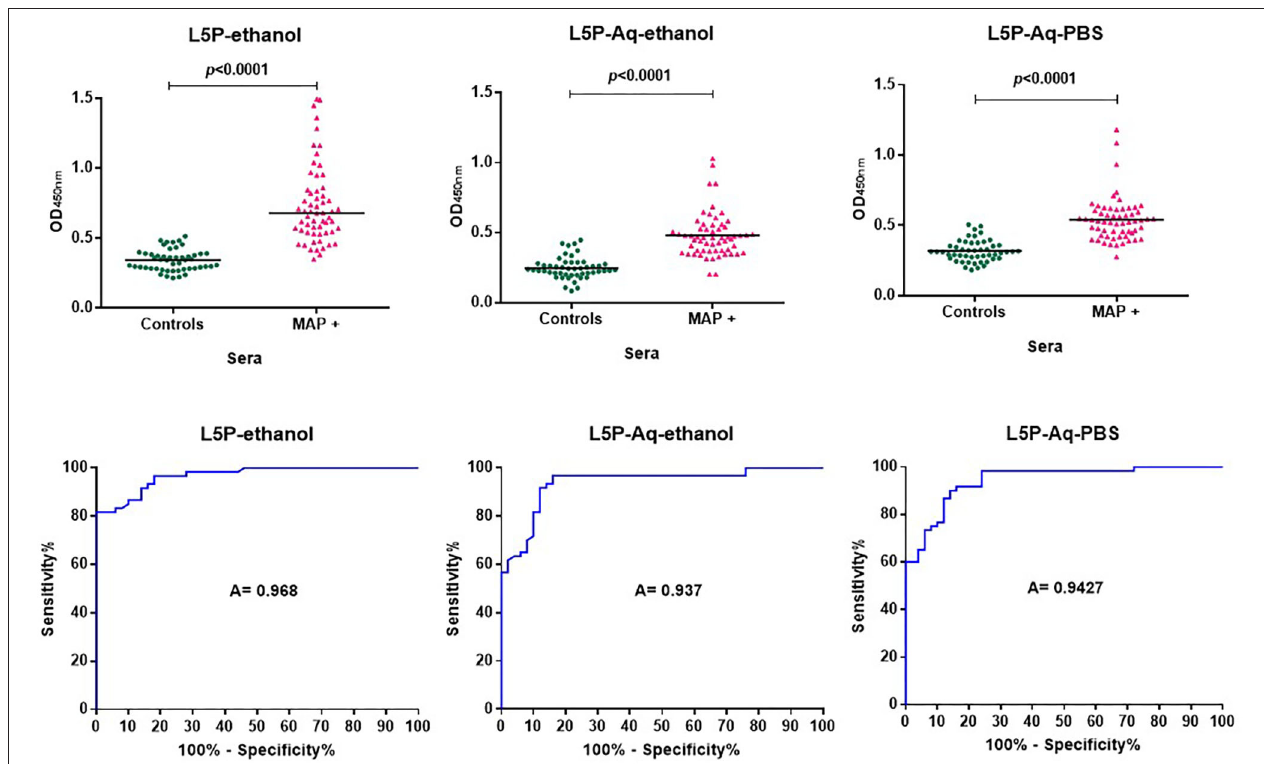
FIGURE 2 | ROC analysis of antibody response of bovine sera against L5P and it hydrosoluble variant L5P-Aq. Analysis performed on a bank of sera including 60 MAP positive (MAP + ) and 50 control animals, using a L5P coated in ethanol, L5P-Aq in ethanol or L5P-Aq in PBS. All results are expressed as individual OD and were compared by ROC analysis. Serum samples were tested in triplicate. The horizontal bars indicate median. A, Area under the receiver operating characteristic curve. Significantly different when p < 0.05.